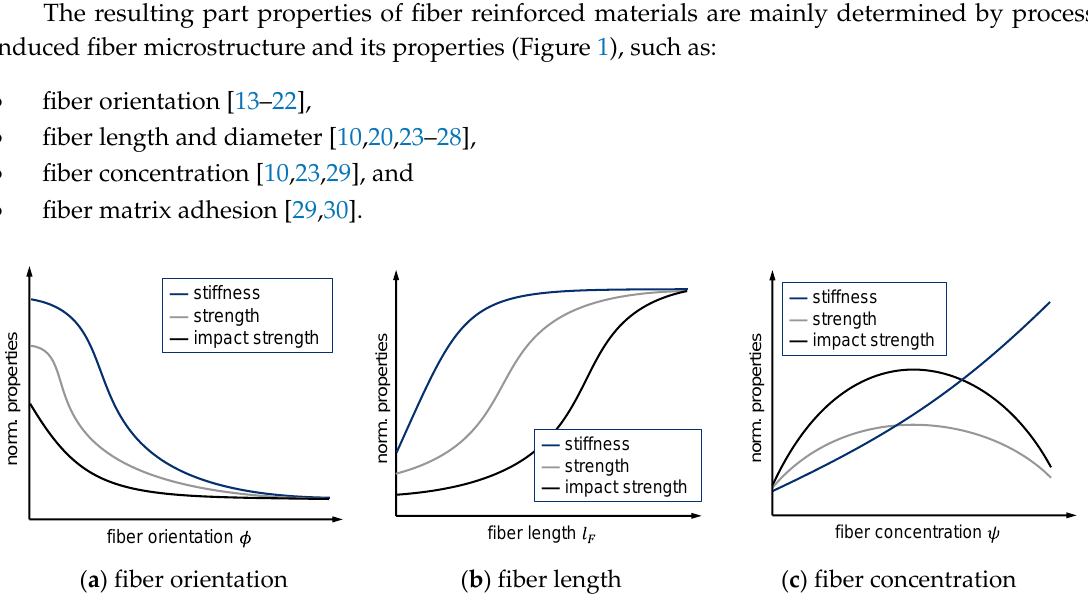
Figure 1. Influence of fiber orientation, length, and concentration on the resulting mechanical properties (schematically) according to [16,26,29].